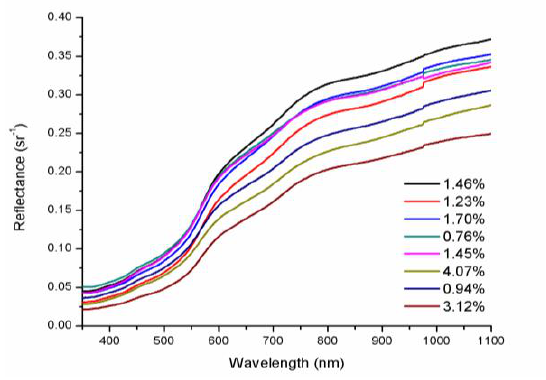
Figure 1. The spectral characteristic curves of the soil Figure 1 showed that the soil spectral reflectance levels increased with the wavelength in the band region of 450-1100 nm. At a given wavelength, the reflectance level decreased with increasing soil moisture content. The reflectance difference increased with the wavelength over the band region of 600